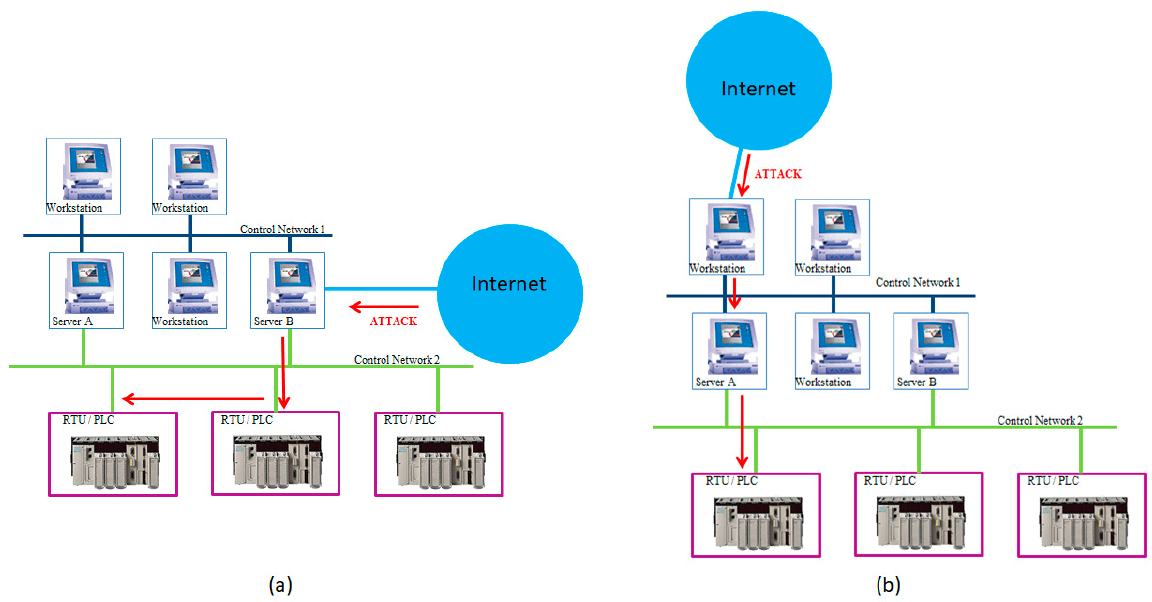
Figure 3. Two types of attack: ( a ) horizontal—between devices of the same subnetwork; ( b ) vertical—through subnets.